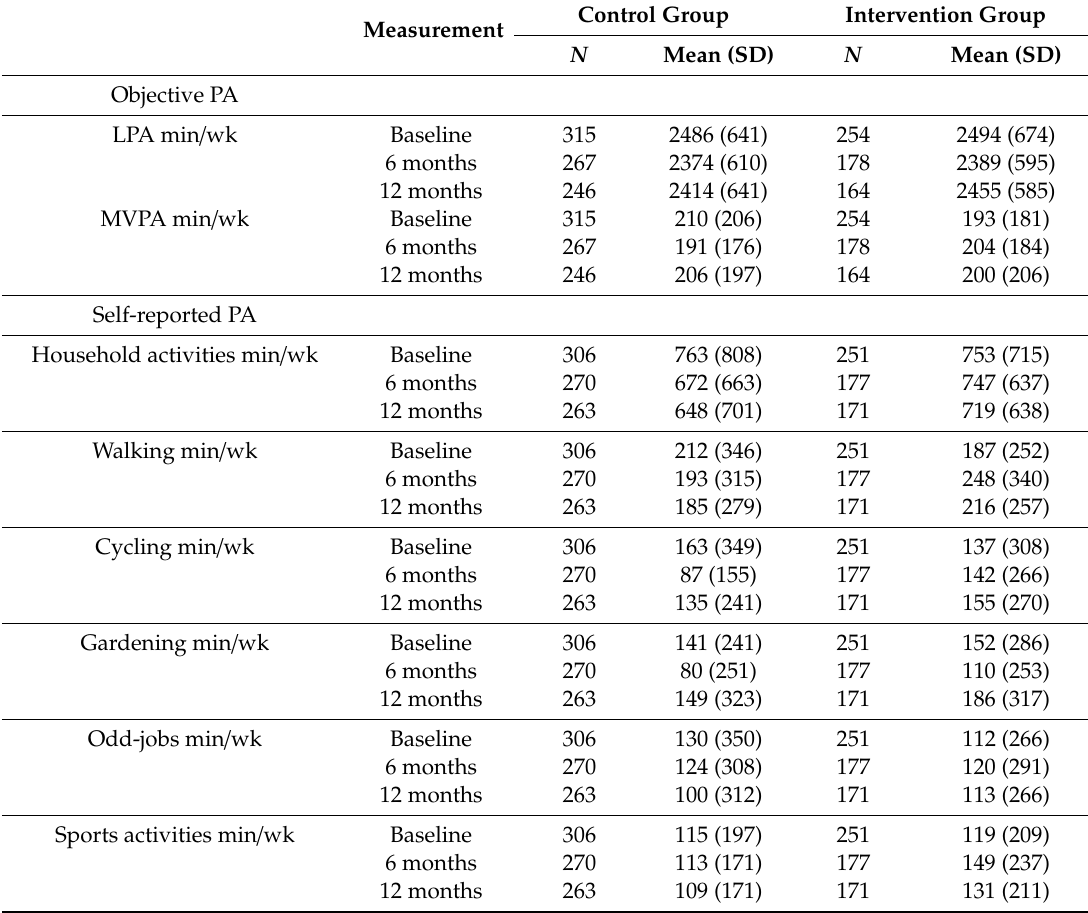
Table 2. Raw outcomes at baseline and follow-up measurements by treatment group